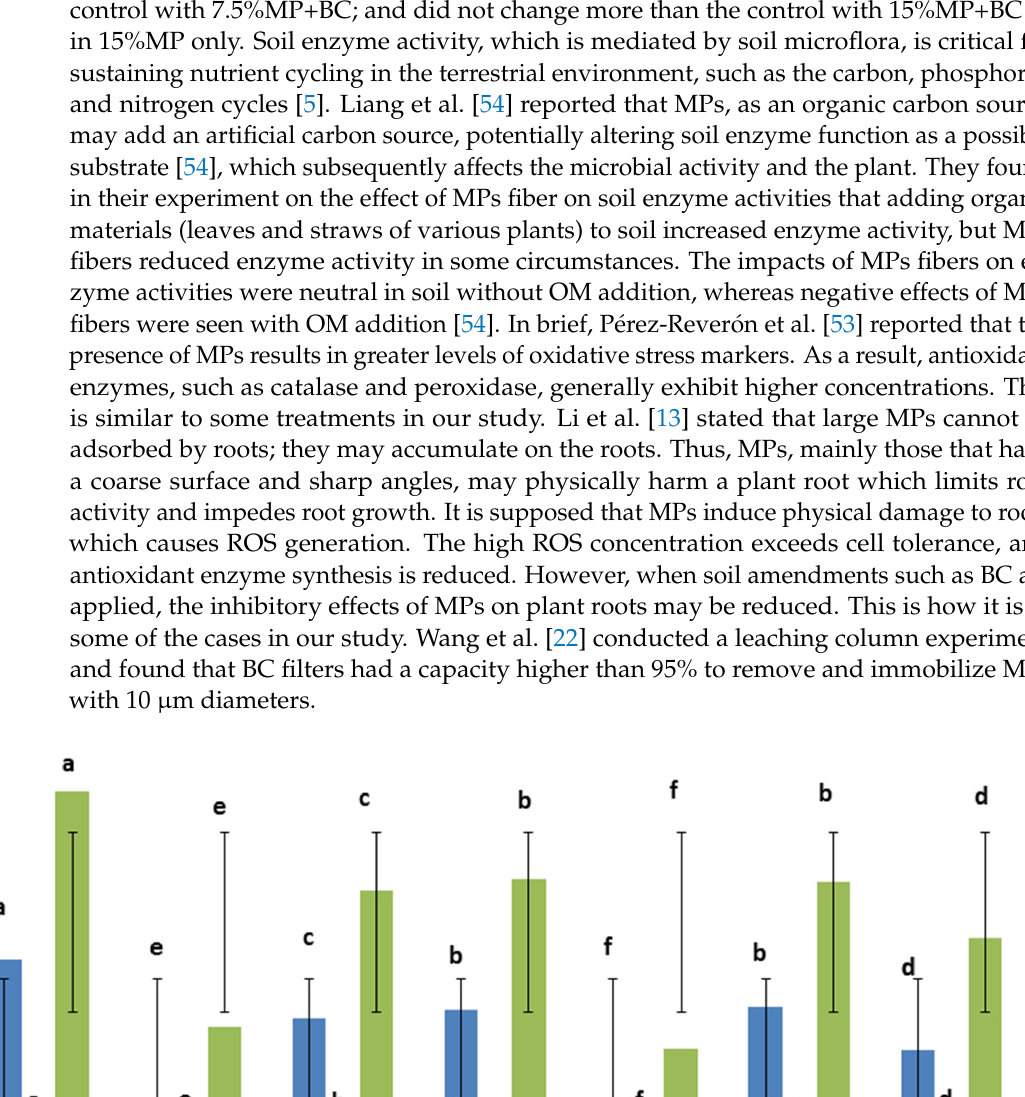
Table 5. One way analysis of variance of plant properties affected by microplastic and biochar .